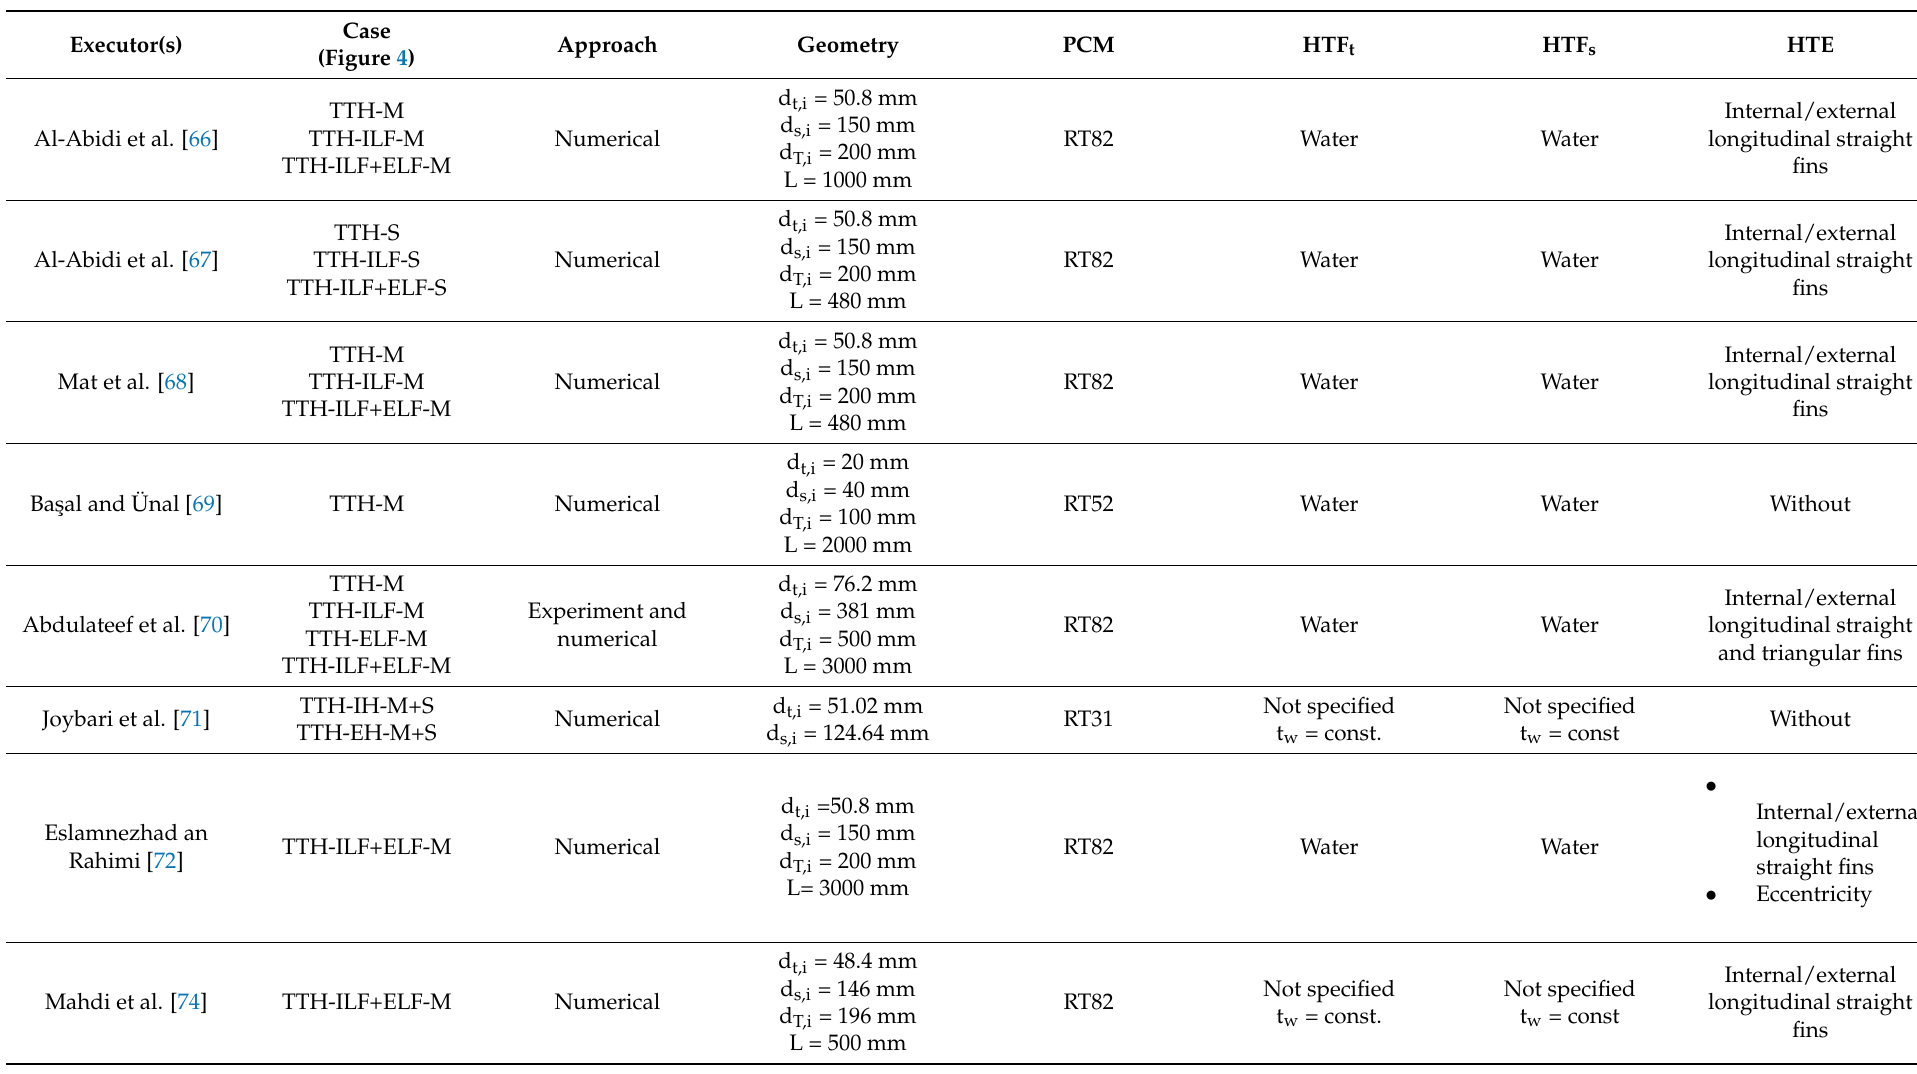
Table 4. Studies dealing with horizontal triplex-tube